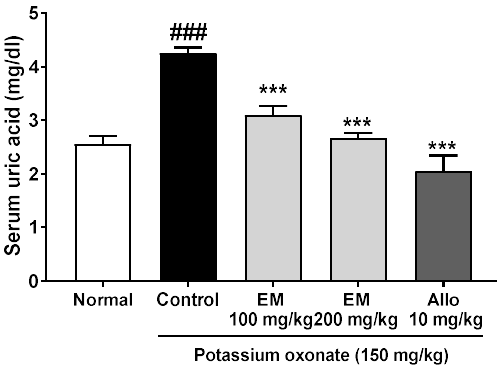
Figure 1. The effects of eggshell membrane (EM) on serum uric acid in hyperuricemic rats (1-day treatment duration) ( n = 5 per group). Allo, allopurinol. ### p < 0.001 vs. the normal group; *** p < 0.001 vs. the potassium oxonate group.